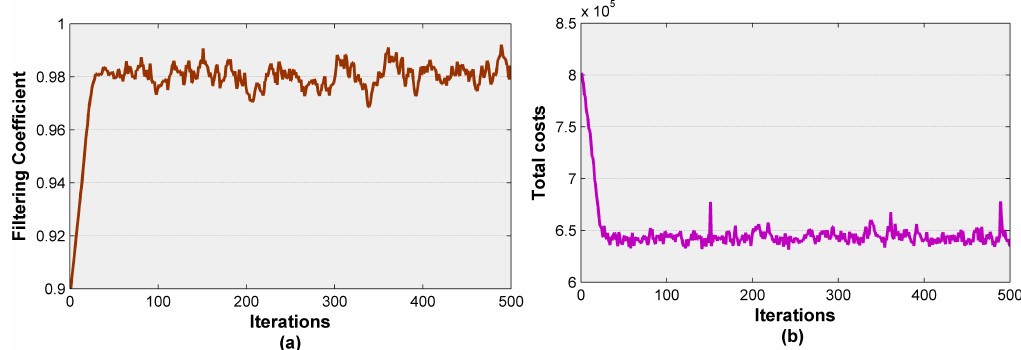
Figure 6. Iteration of algorithm with respect to optimal solution: ( a ) filtering coefficient and optimal value; ( b ) total costs.